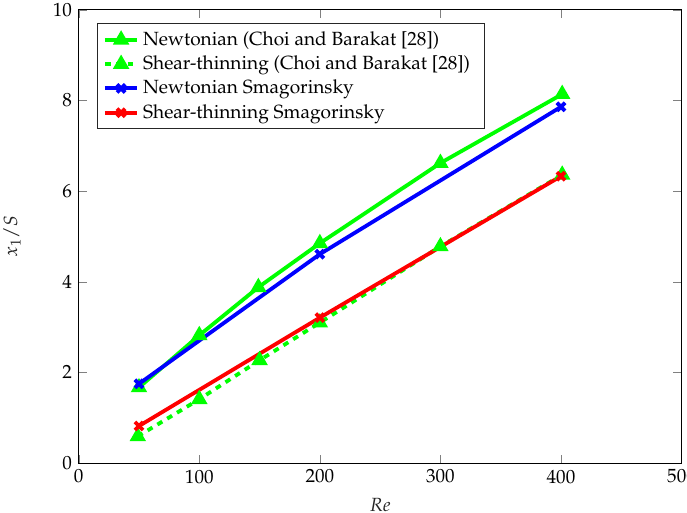
Figure 7. Time and spatially averaged primary recirculation x 1 normalised by step height S for Newtonian (blue line) and shear-thinning (red line) blood rheology plotted as a function of Reynolds number. Numerical data from Choi and Barakat [28] (Newtonian - solid green line and shear-thinning - dashed green line).